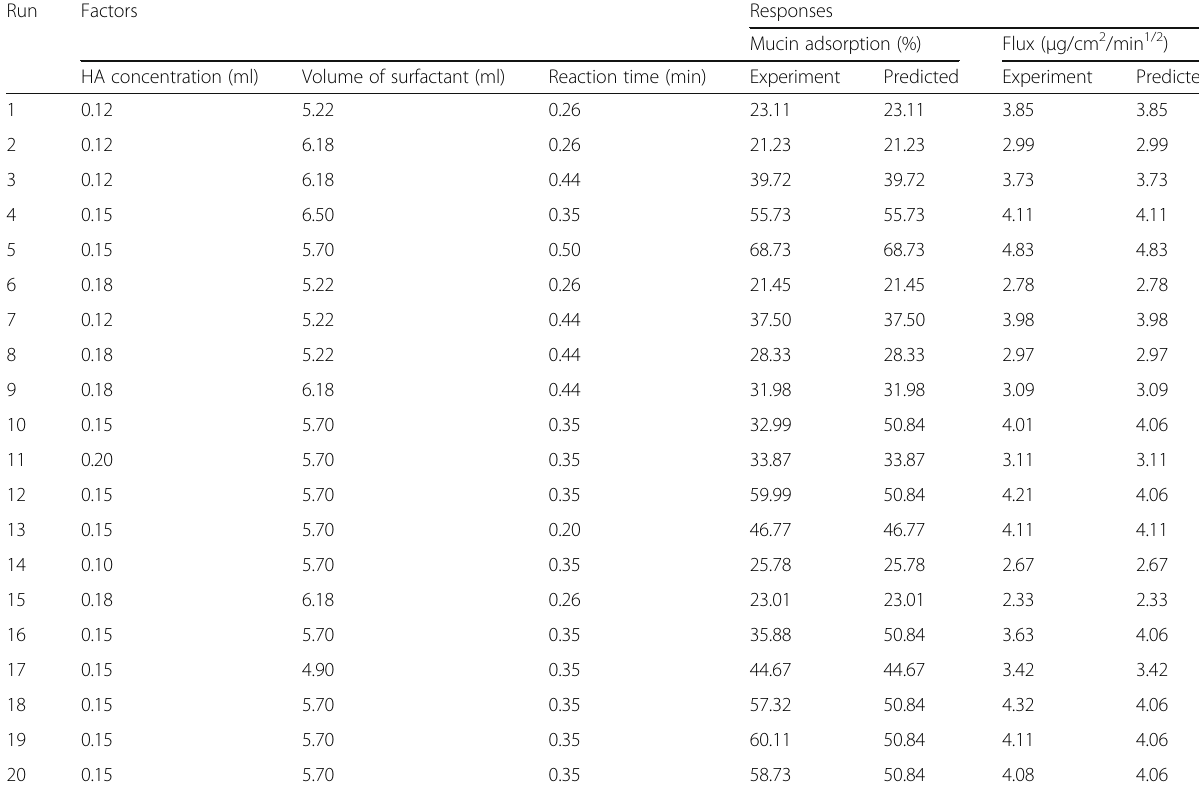
Table 3 Comparison of experimental results with ANN predicted results Run Factors